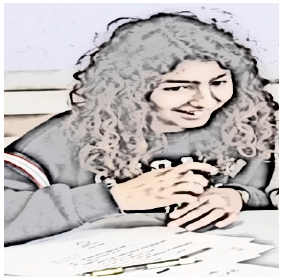
Figure 8. Maise (277) with an excited tone.